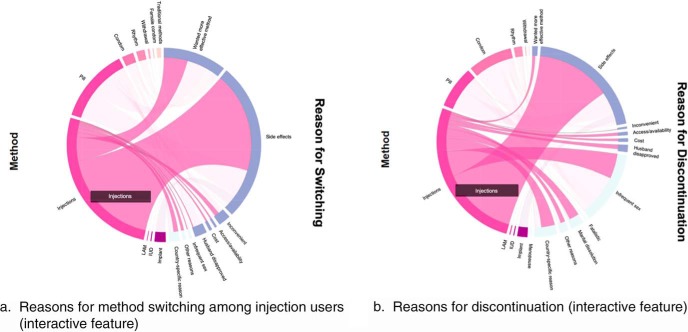
Reasons for Contraceptive Method Discontinuation Among Women Sampled in the 2014 Kenya Demographic Health SurveyThese chord diagrams display the reasons for switching to another method (Panel a) or discontinuing (Panel b). Colors along the left-hand side encode method effectiveness. The colors along the right-hand side encode reasons for discontinuation into “in need” (dark blue) and not “in need” (light blue). In both cases, the most common reason women quit using injections was because of side effects (both quitting and switching). Comparing Panel (a) to (b), about half of women who quit using any method were still in need while women who switched were still in need.